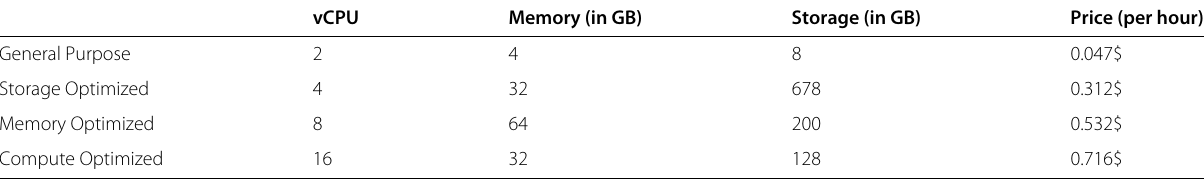
Table 2 VM instance types, their resource configurations and hourly rental prices